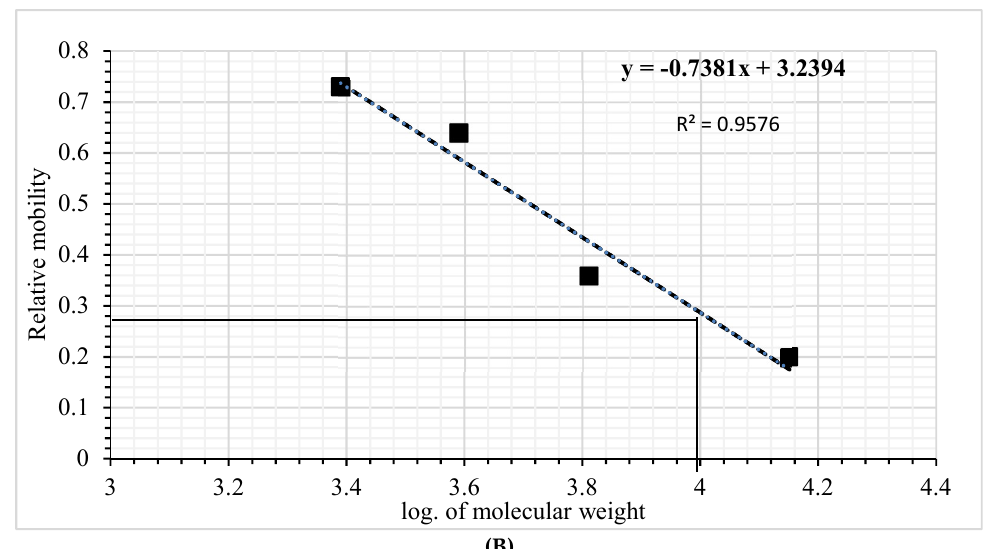
Figure 4. The molecular weight of antibacterial peptide production from Saccharomyces cerevisiae was determined by electrophoresis method. ( A ) Sodium dodecylsulfate polyacrylamide gel electrophoresis of standard proteins and the antibacterial peptide. ( B ) Relative mobility of standard proteins and the antibacterial peptide.